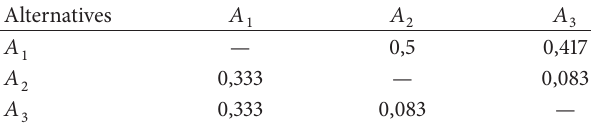
Table 13: The matrix of concordance rates. Table 14: The matrix of discordance